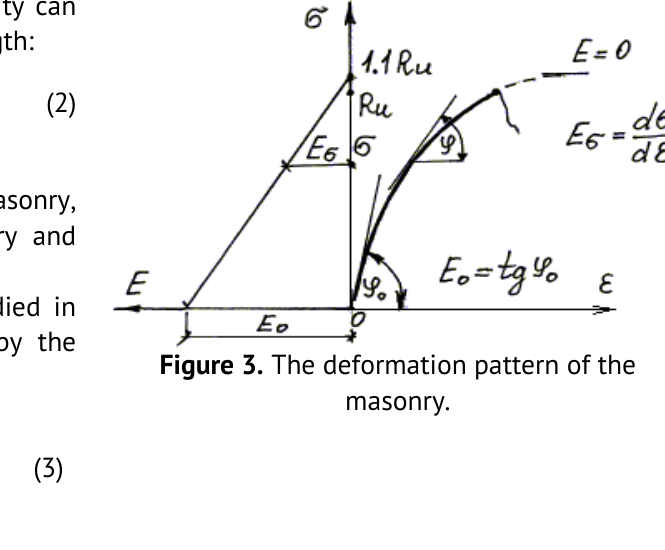
Figure 3. The deformation pattern of the